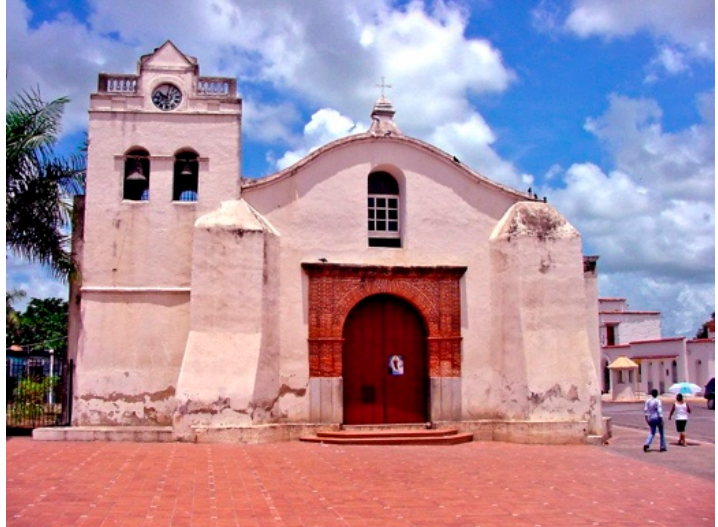
Figure 13. San Dionisio sanctuary, 1572, Higüey, Dominican Republic. Image created by Josue Collado, https://www.pbase.com/image/65323407, accessed 11 June 2021.